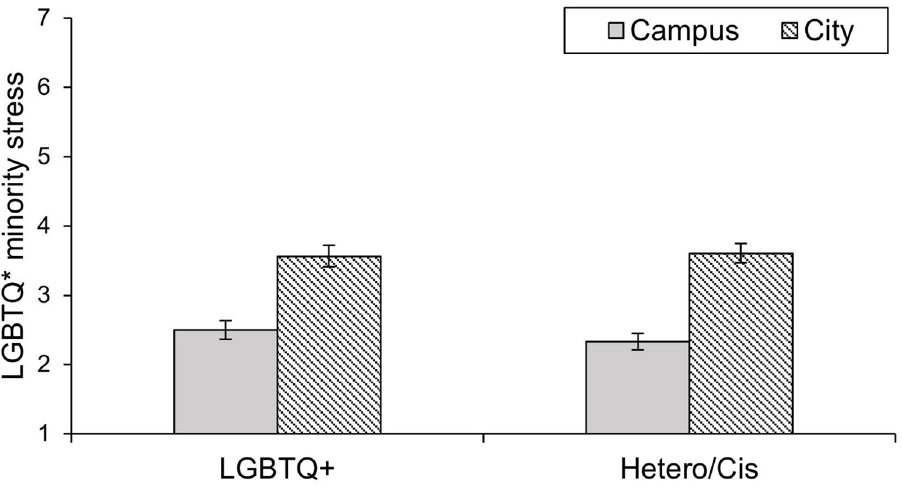
Fig 3. Perception of LGBTQ � minority stress by LGBTQ � and Hetero/Cis participants in the contexts of a campus and a city in Study 2. Error bars represent +/– 1 SEM .